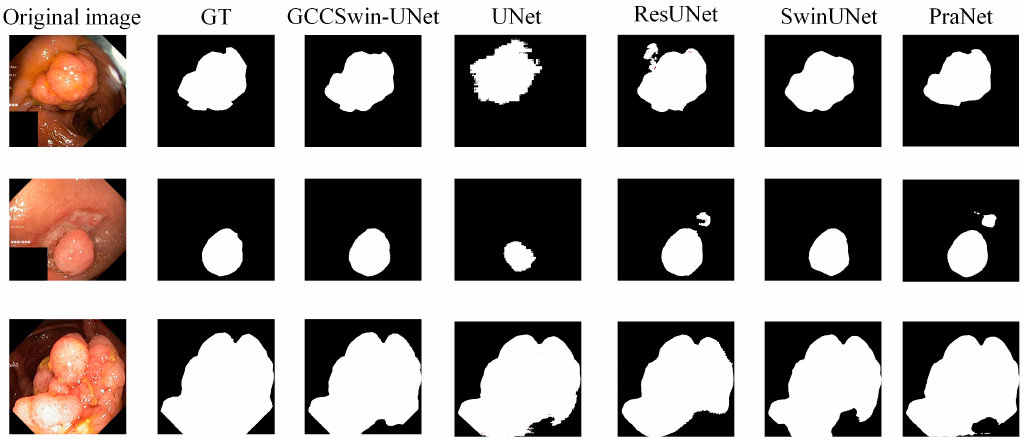
Figure 6. Visual comparison of polyp region segmentation from state-of-the-art methods. Finally, we screened some colonoscopic images with lesion features for testing. The results are shown in Figure 7. When faced with noise such as blood mucosa, its segmen- tation results are accurate and clear with intact edges, proving its superiority.